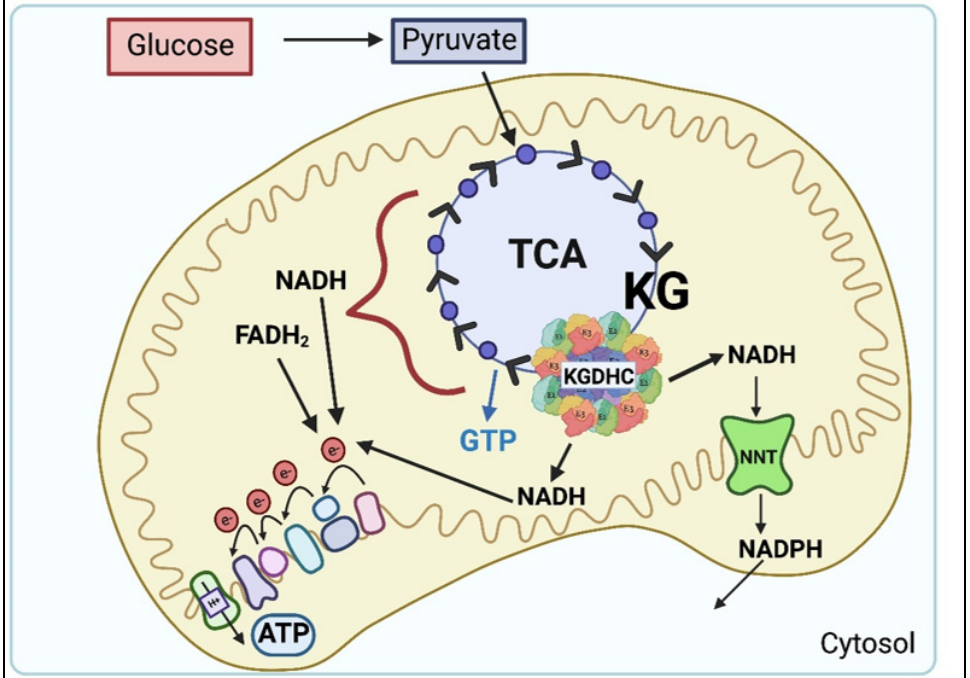
Figure 1. Overview of the traditional roles of α -ketoglutarate dehydrogenase complex (KGDHC). The tricarboxylic acid (TCA) cycle oxidizes pyruvate to produce NADH, FADH2 and GTP. Generally, the electrons from NADH and FADH2 are passed through a series of protein complexes to produce large amounts of ATP. The α -ketoglutarate dehydrogenase complex (KGDHC) is rate limiting for the TCA cycle. The NADH that is produced by KGDHC can be directed to nicotinamide nucleotide transhydrogenase (NNT) for conversion to NADPH, which is critical for oxidative carboxylation and maintaining cellular redox state.